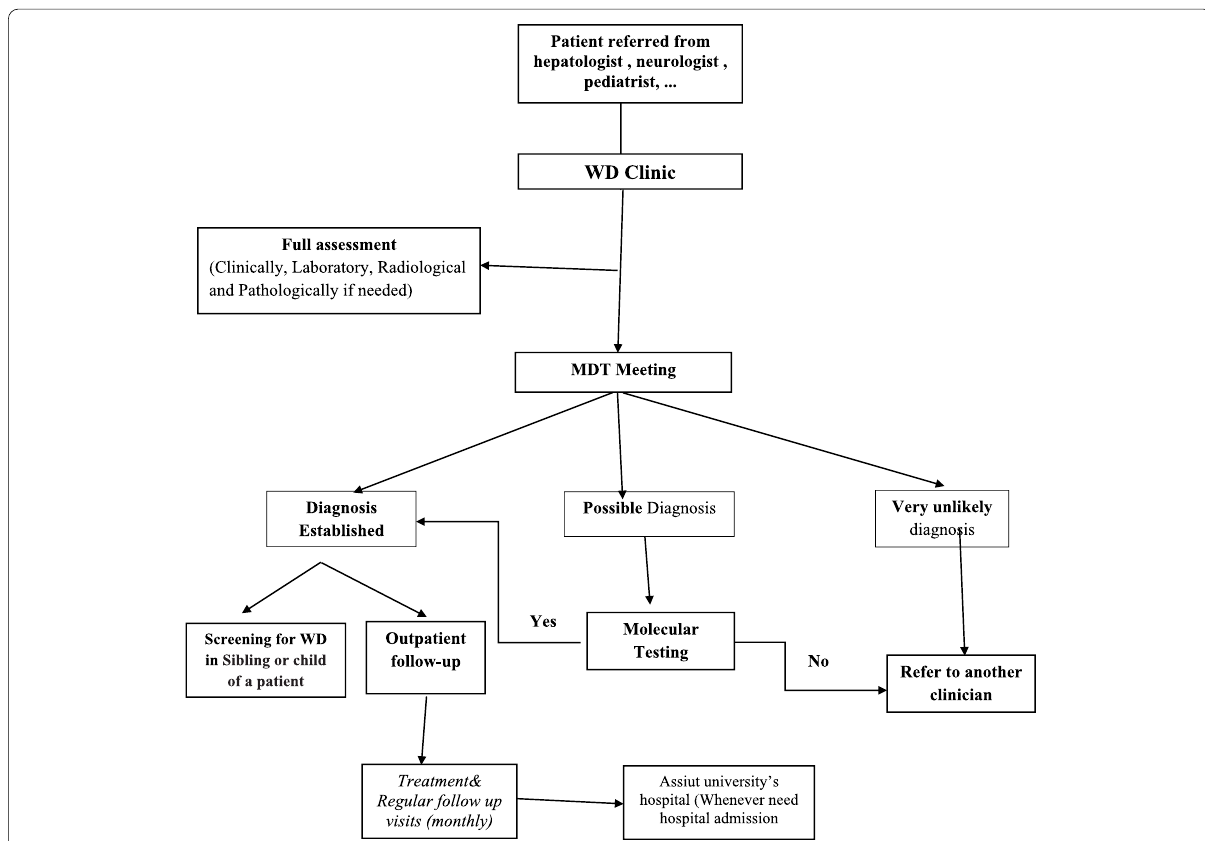
Fig. 1 Flowchart for the WD patient’s pathway in the Assiut Liver